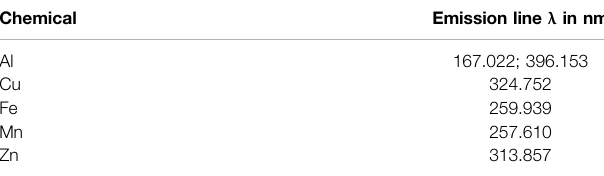
TABLE 1 | Lines used for ICP-AES determination of selected